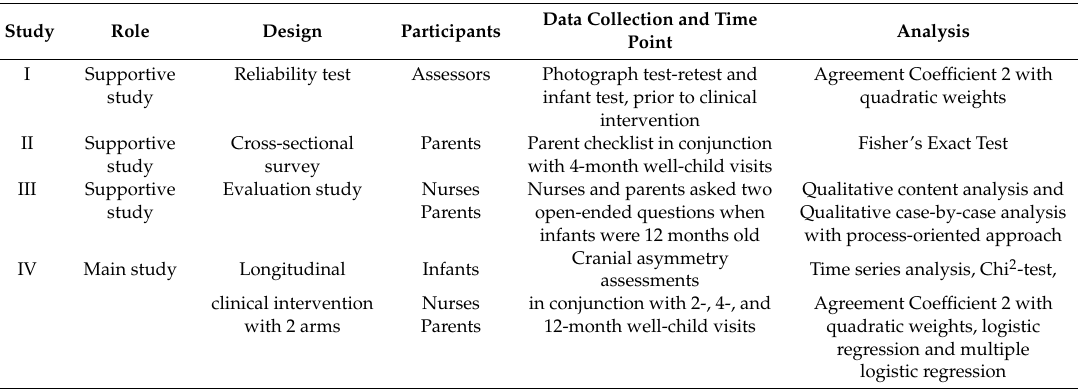
Table 1. Overview of methods and